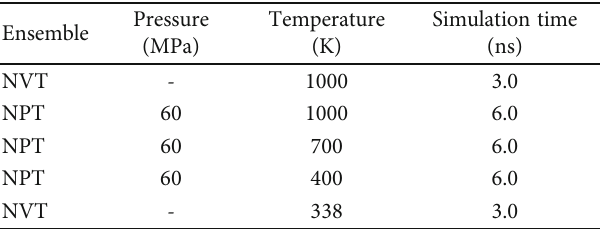
Figure 2: Schematic diagram of shale organic nanopore construction process. Table 1: MD simulation steps for constructing shale organic